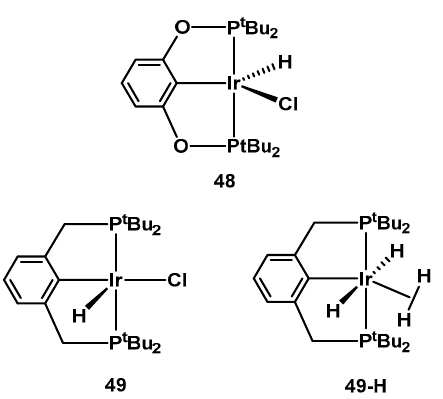
Figure 2. Iridium pincer catalysts investigated by Jensen for hydrogen release from